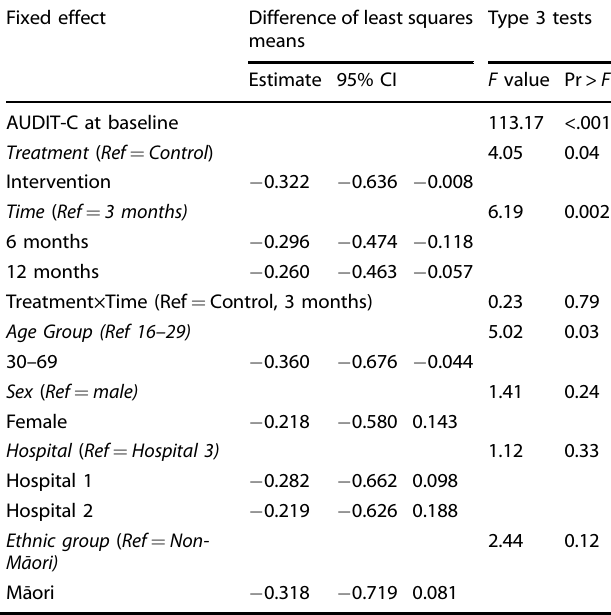
Table 3. Results of mixed modelling for the primary